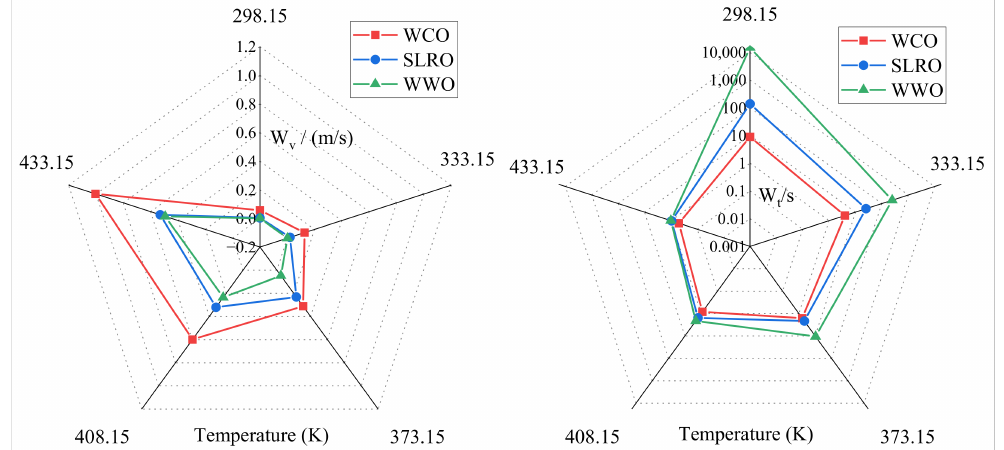
Figure 7. W v and W t varies with temperature at the interface of bio-oils-RTFOT 360